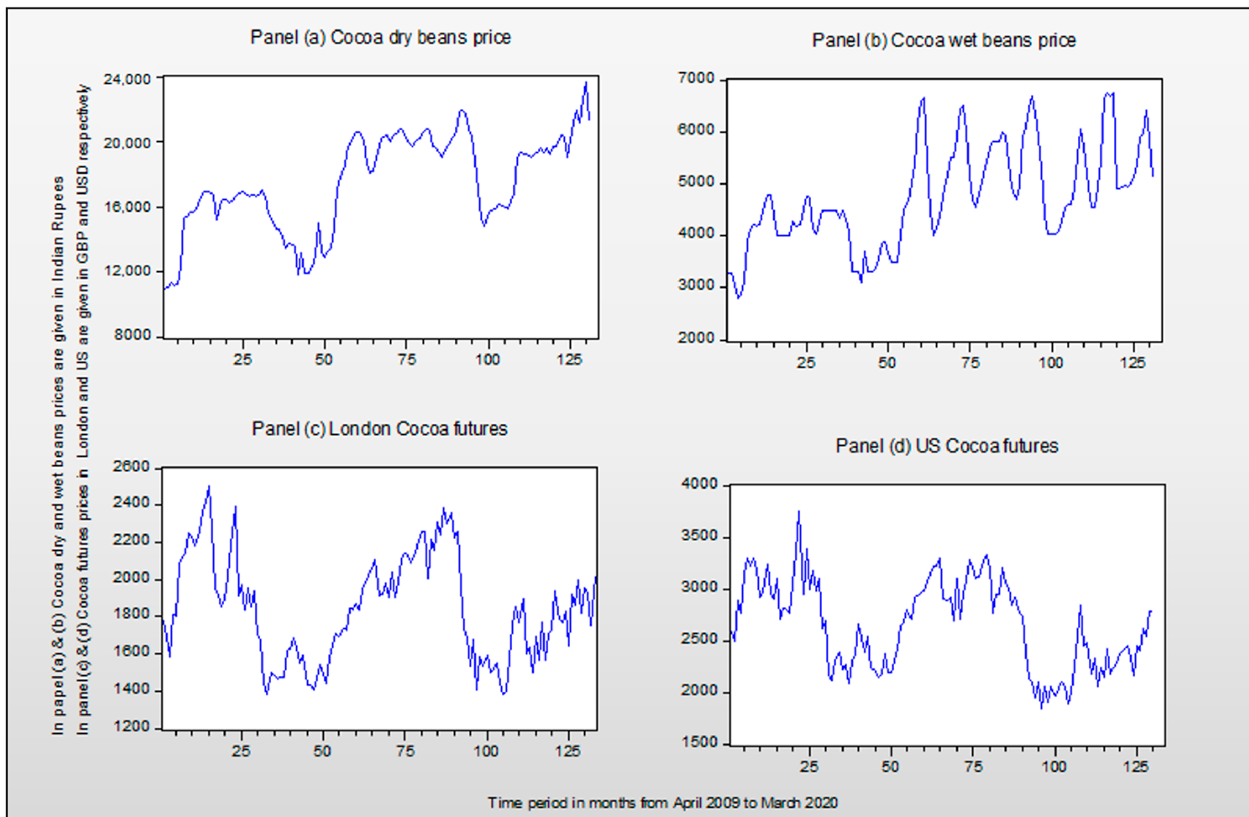
Figure 1. Time plot of Cocoa spot price series and ICE Cocoa futures price series. Table 1. Unit-root test results. Source: Authors processing.